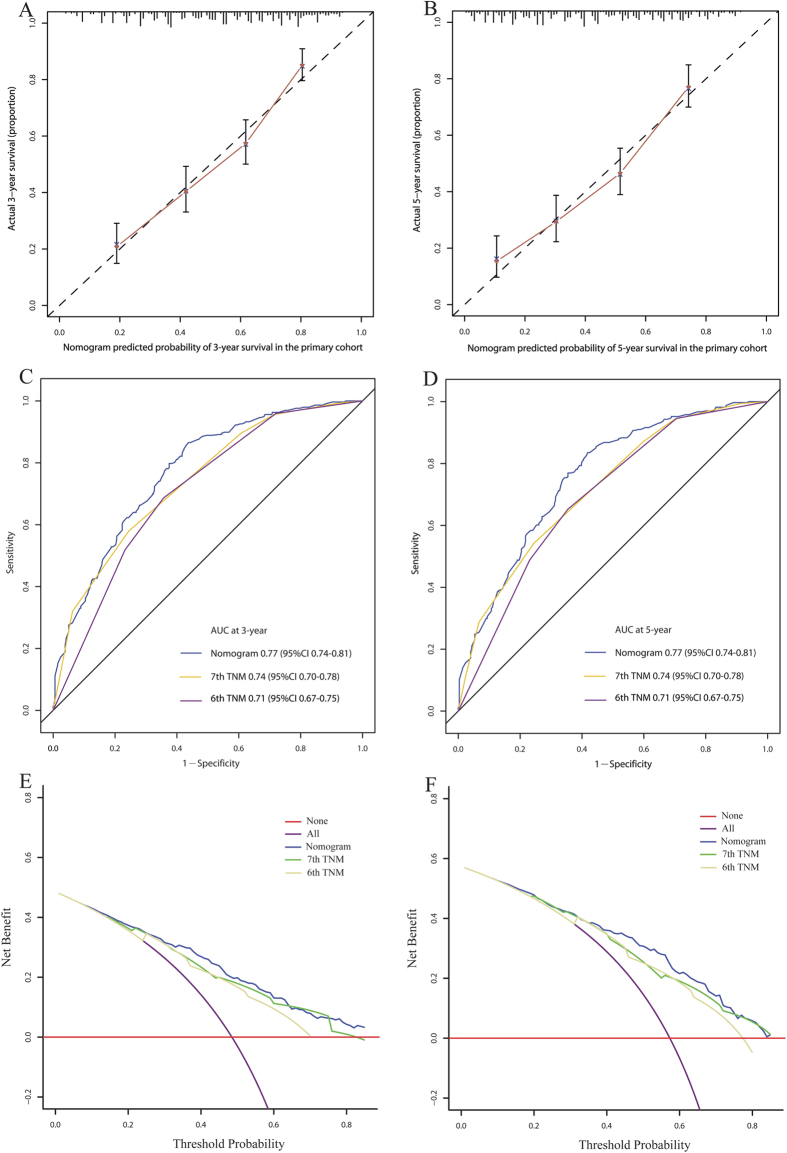
The calibration curve for predicting patient survival at 3-year (A) and 5-year (B) in the primary cohort.Time-dependent receiver operating characteristic (ROC) curves by nomogram, 6th AJCC-TNM staging system and 7th AJCC-TNM staging system for 3-year (C) and 5-year (D) OS in the primary cohort. Decision curve analyses by nomogram, 6th AJCC-TNM staging system, and 7th AJCC-TNM staging system for 3-year (E) and 5-year (F) OS in the primary cohort.